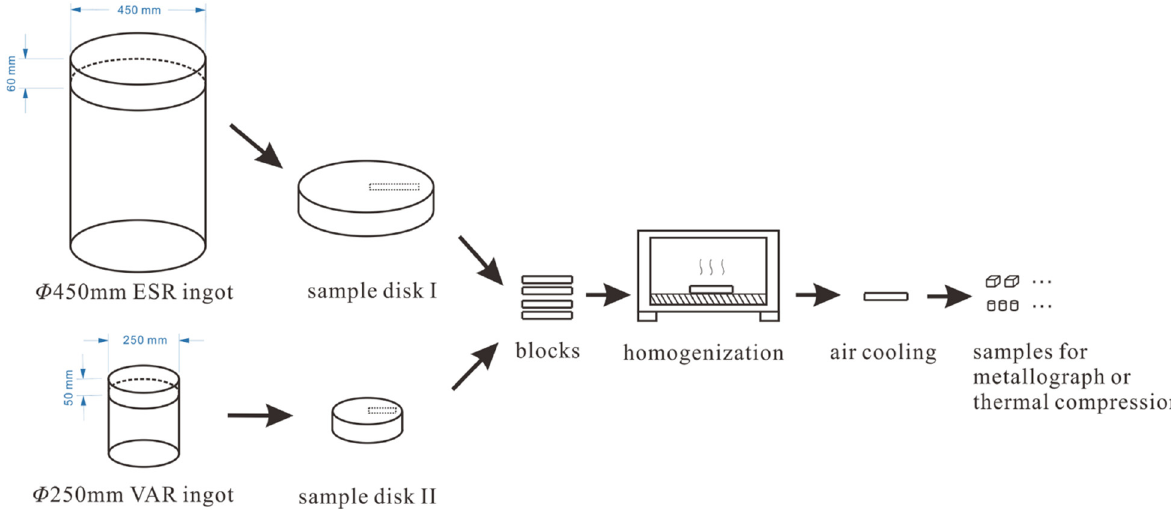
Figure 1: Schematic diagram of preparation procedure of